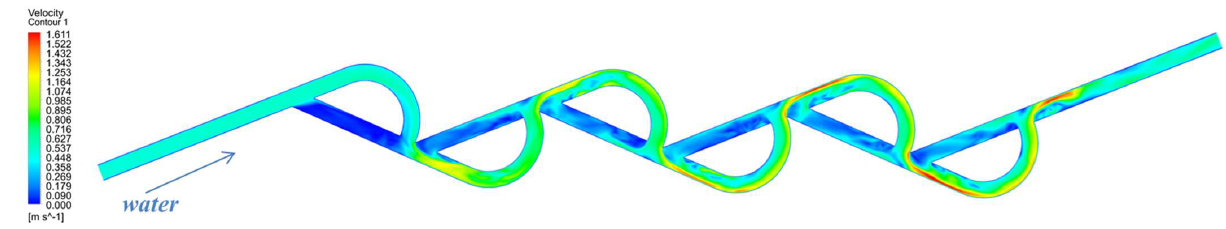
Figure 8. Velocity distribution cloud map .